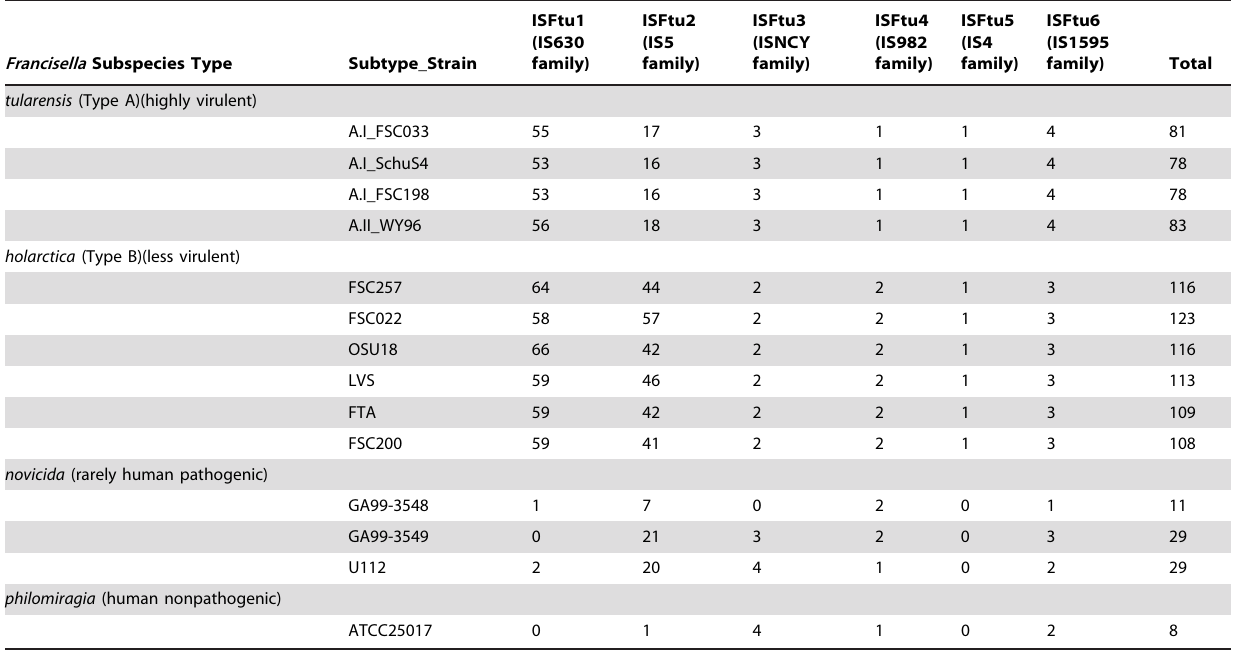
Table 2. IS Element Summary